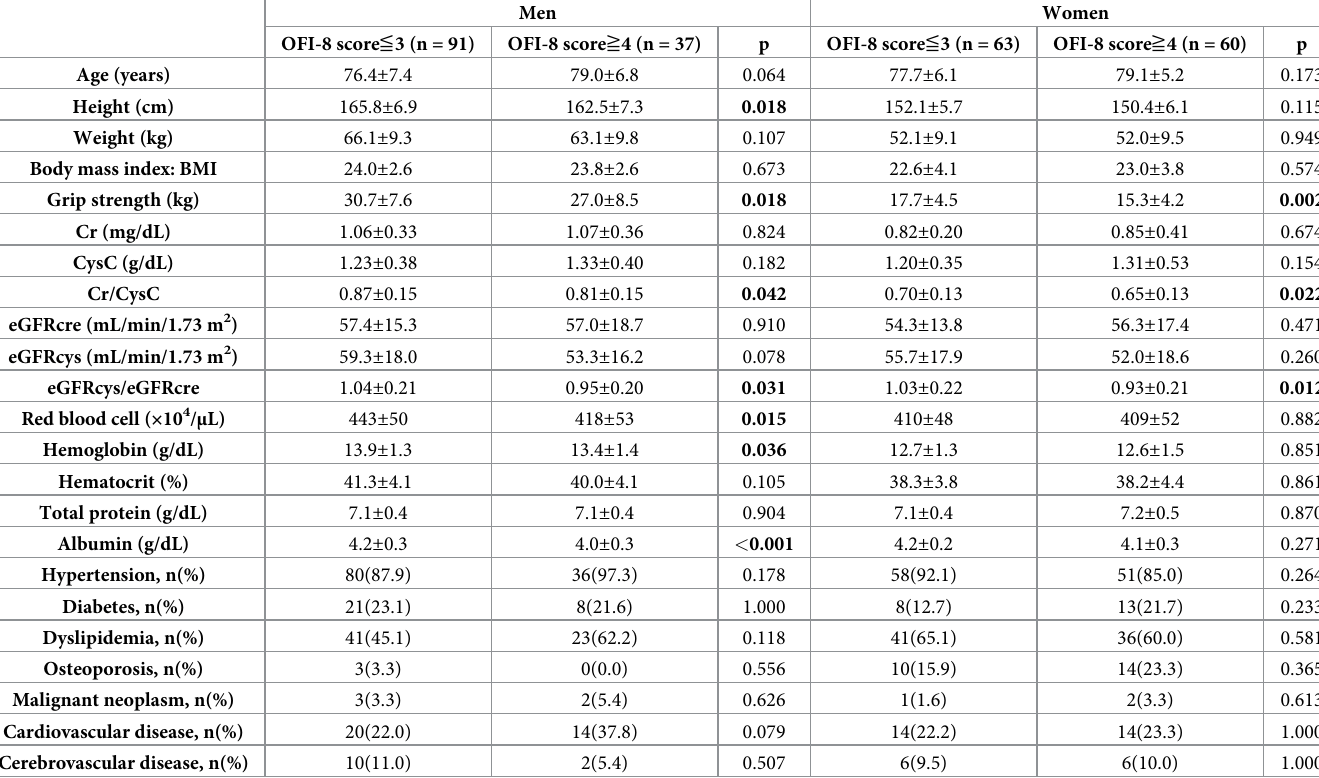
Table 3. Characteristics of participants with and without OFI-8 scores of �